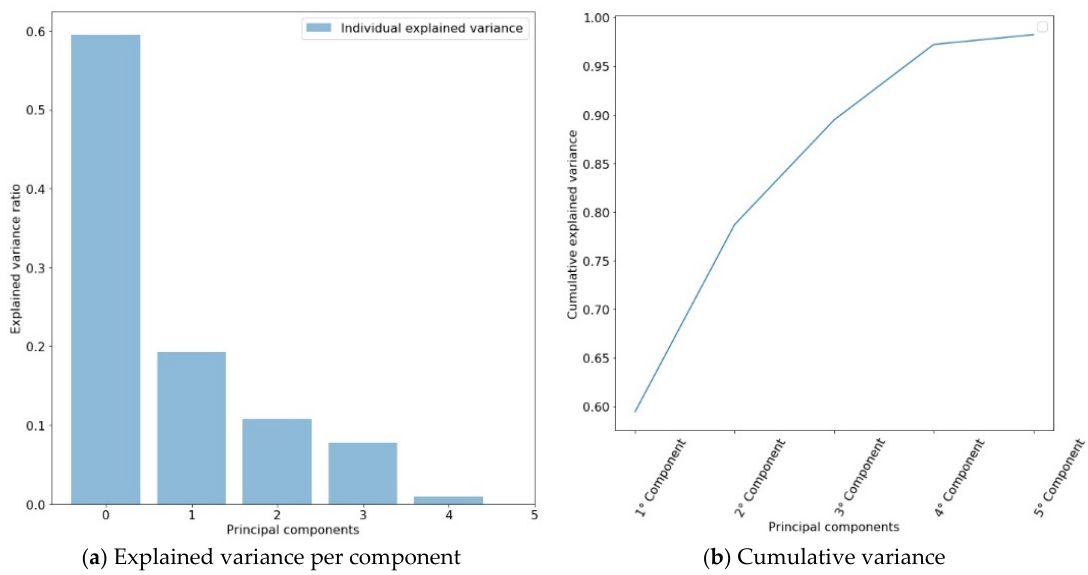
Figure 5. Explained variance per component. Table 3. Selected variables from PCA analysis.